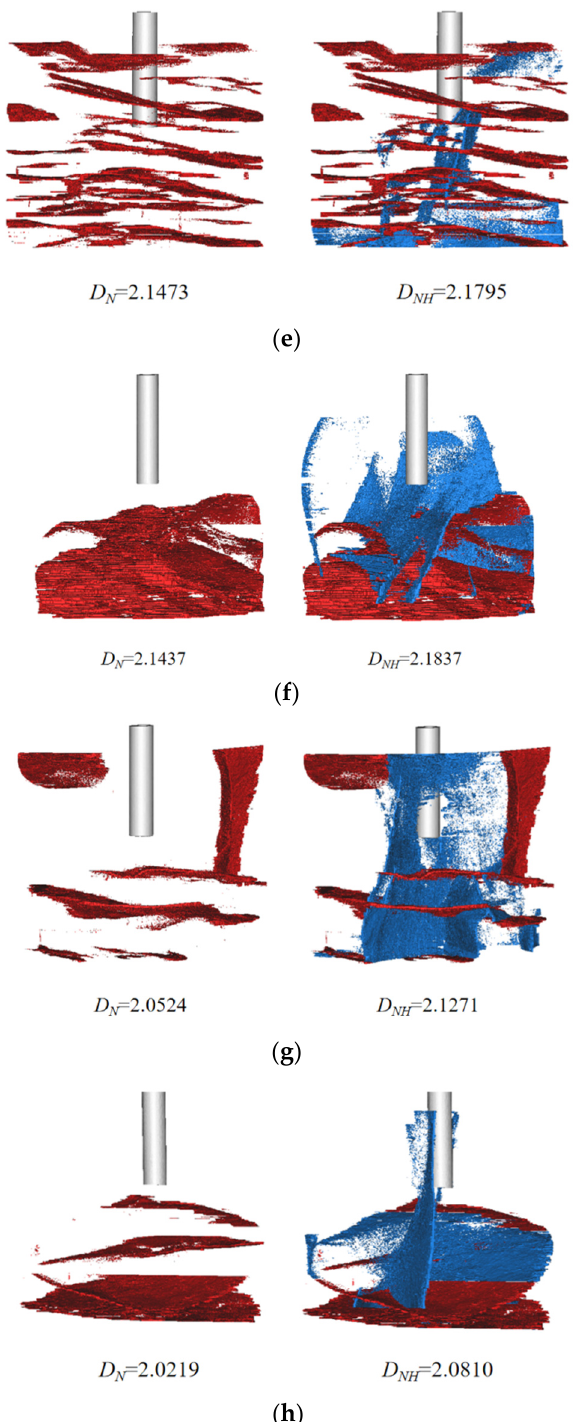
Figure 8. Fractal calculation results for all the samples. ( a ) Before and after the fracturing experiment. ( b ) Fractal calculation of sample H2 before and after the fracturing experiment. ( c ) Fractal calculation of sample H3 before and after the fracturing experiment. ( d ) Fractal calculation of sample H4 before and after the fracturing experiment. ( e ) Fractal calculation of sample F1 before and after the fracturing experiment. ( f ) Fractal calculation of sample F2 before and after the fracturing experiment. ( g ) Fractal calculation of sample F3 before and after the fracturing experiment. ( h ) Fractal calculation of sample F4 before and after the fracturing